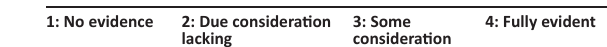
TABLE 3-A2: Model validation process scorecard. Validation